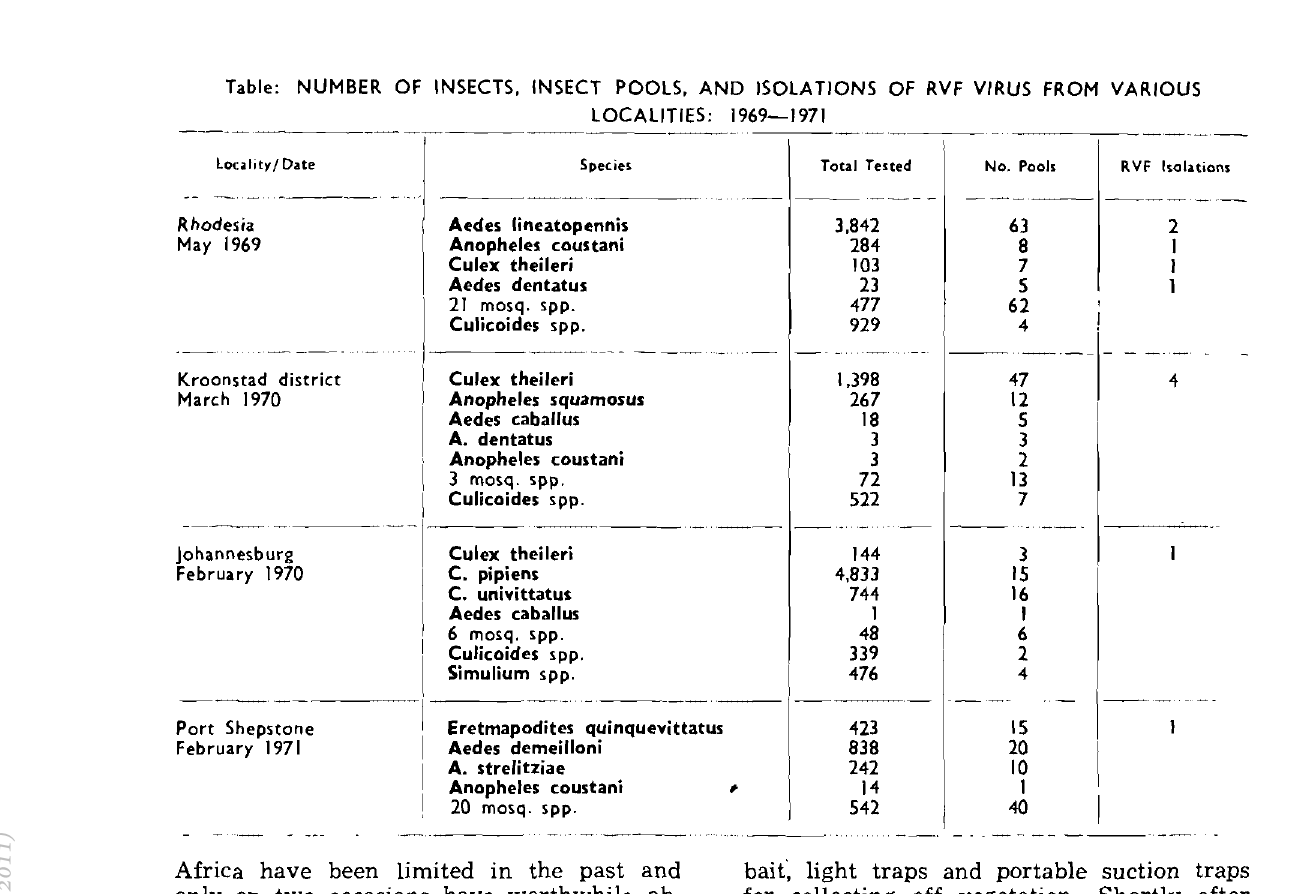
Table: NUMBER OF INSECTS, INSECT POOLS, AND ISOLATIONS OF RVF VIRUS FROM VARIOUS